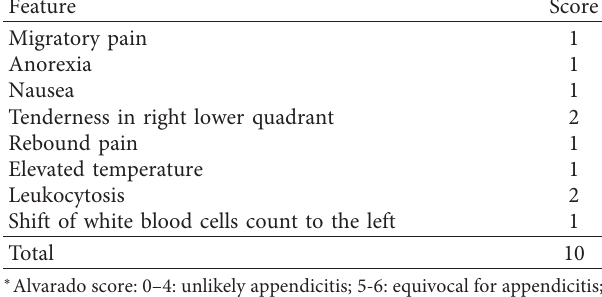
Table 1: Alvarado score for diagnosis of acute appendicitis ∗